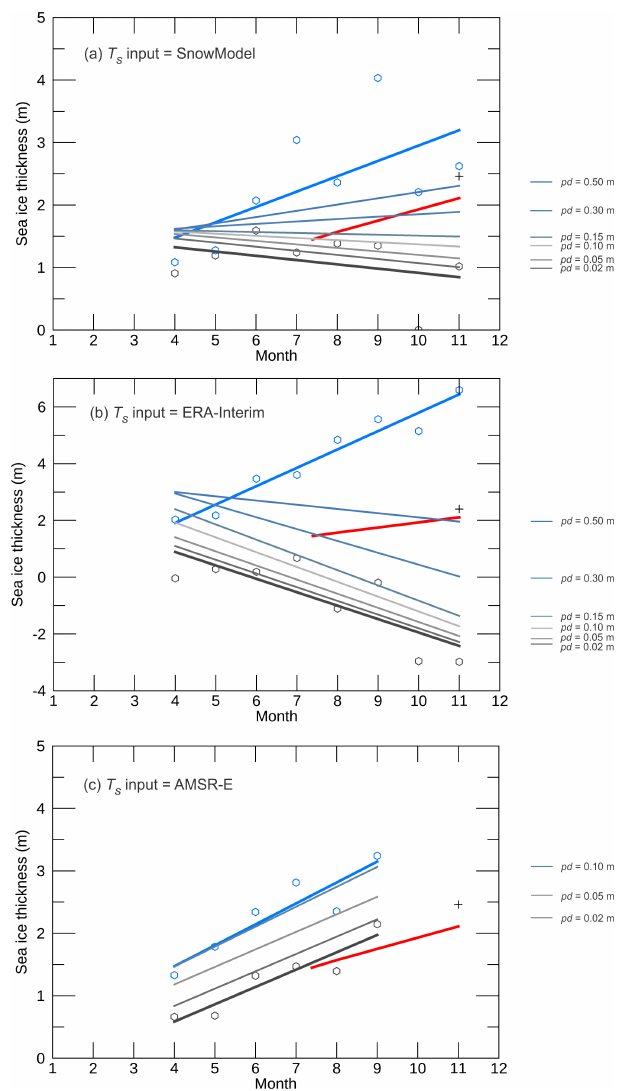
Figure 5. Sea ice thickness trends derived by CS-2 freeboard mea- surements with snow data provided by (a) SnowModel, (b) ERA-I and (c) AMSR-E. Grey dots and bold linear fit are sea ice thick- ness calculated using Eq. (1). Blue dots and bold linear fit show the trends using Eq. (2) and the thin lines between them show Eq. (3) with varying penetration factors ( P d ). The red line shows sea ice thickness from in situ measurements of consolidated sea ice thick- ness with a tape measure taken in July and November in one lo- cation in the south of McMurdo Sound, joined assuming a constant growth rate. The black plus sign is the mean “mass-equivalent thick- ness” from all in situ measurements in November. This is slightly thicker than the end-of-season thickness indicated by the red line given that it takes account of the influence of the sub-ice platelet layer. This black plus sign is what CS-2 thickness should be com- pared to (see text).